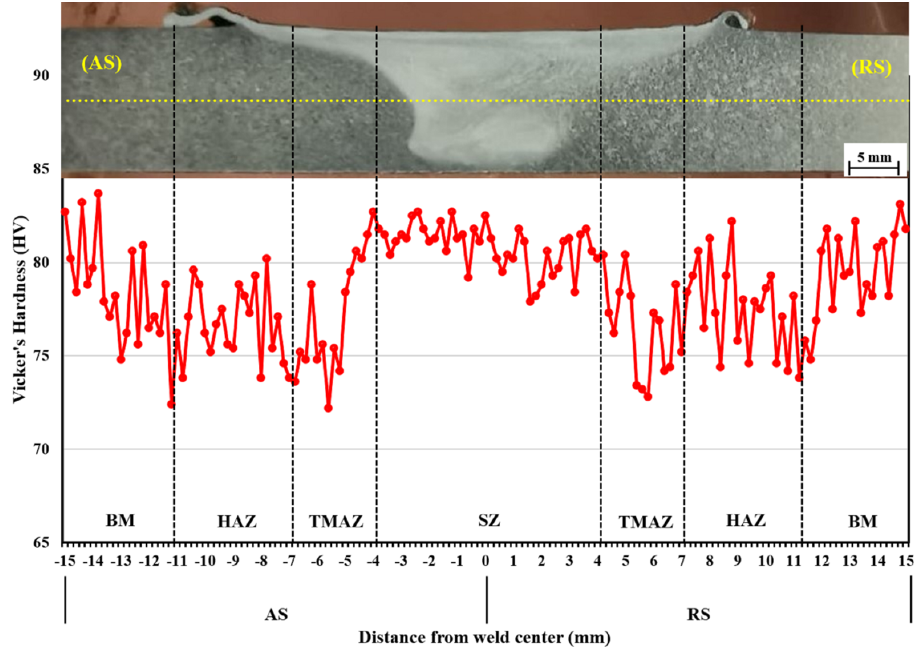
Figure 14. The hardness values at a rotational speed of 1200 rpm, a welding speed of 10 mm/min, and with a threaded cylindrical tool pin profile.